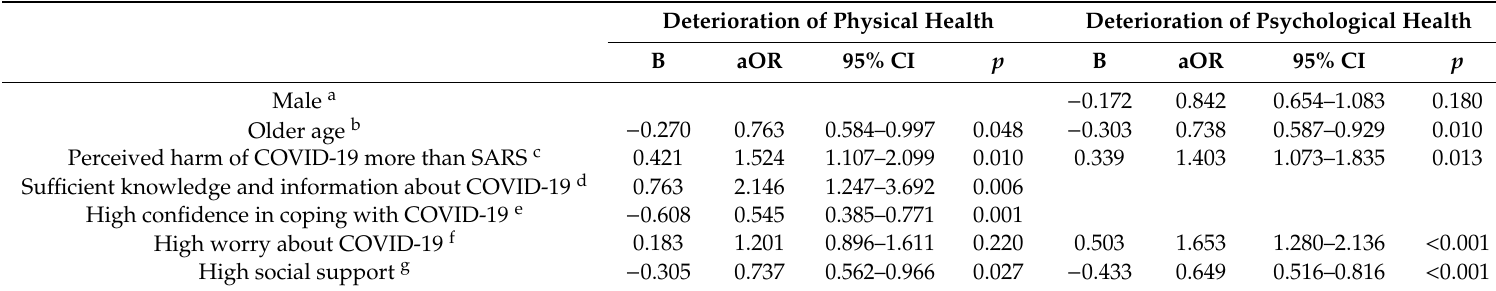
Table 3. Factors related to the deterioration of physical and psychological health status: multivariate logistic regression